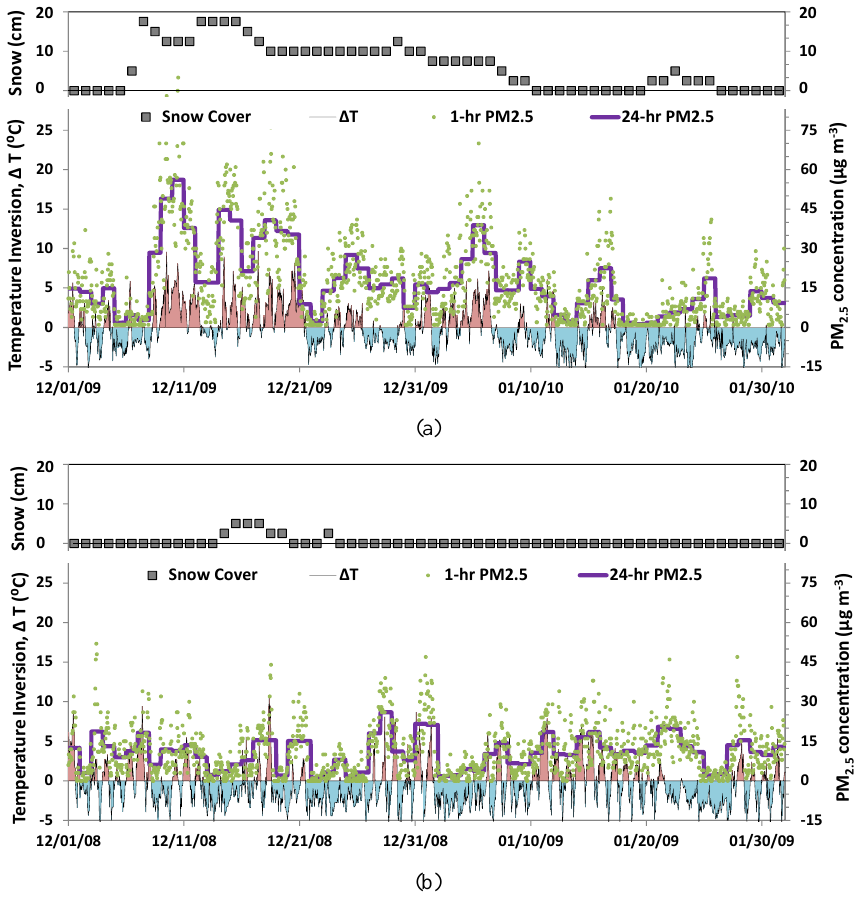
Fig. 2. Snow cover (daily), temperature inversion ( 1T = T Galena − T Rail ) , and corresponding PM 2 . 5 mass concentrations by beta attenuation monitor (BAM) during: (a) December 2009–January 2010, and (b) December 2008–January 2009. 1T > 0 (i.e., with inversion) and 1T < 0 are marked by red and blue,